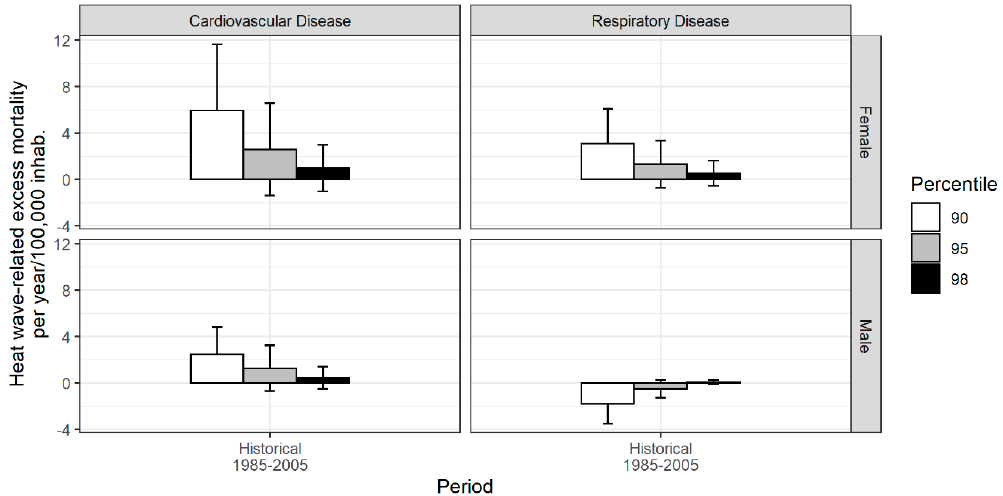
Figure 3. Historical period (1985–2005): Heat wave-related excess mortality of elderly people per year in each 100,000 inhabitants from cardiovascular and respiratory diseases for female and male genders. The colors are percentiles of maximum temperature (90th, 95th and 98th).